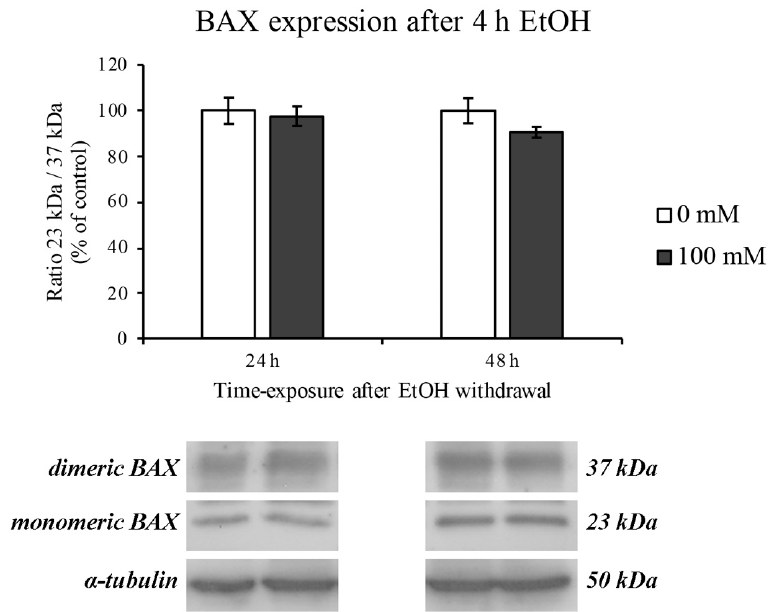
Figure 4. BAX expression on RBE4 cells after EtOH withdrawal. Representative Western blotting analysis after EtOH 100 mM withdrawal for 24 and 48 h. Value bars are expressed in percentage of control (untreated cells) as the mean ± S.E.M. of three independent experiments in triplicate.